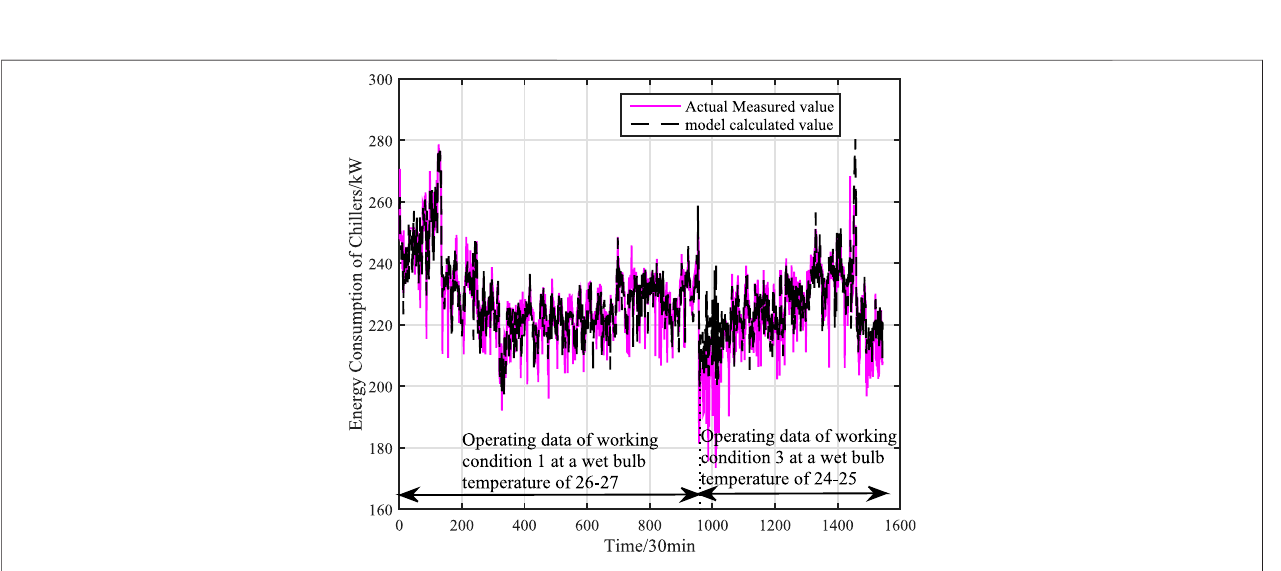
FIGURE 9 | The accuracy of mechanism model under multiple working conditions (working condition 1 and working condition 3).